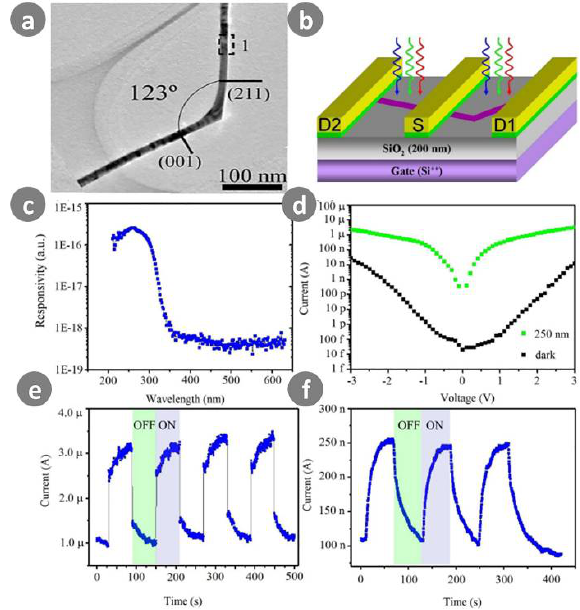
Figure 11. ( a ) Typical TEM image of kinked SnO 2 nanowire, demonstrating the measured angle of 123° between the two arms; ( b ) A sketch for the device composed of straight and kinked nanowire devices from a single crystalline SnO 2 nanowire; ( c ) Spectral photoresponse measured on the kinked nanowire device (Source-Drain1) at a bias of 3 V; ( d ) The comparison of photocurrent on the kinked nanowire device under 250-nm-wavelength incident light illumination (upper, green) and dark (lower, black); ( e , f ) On/off switching test under 250 nm incident light illumination at a bias of 3 V for the kinked nanowire device and straight nanowire device (Source-Drain2), respectively. Ref. [94] Copyright 2015, Royal Society of Chemistry.